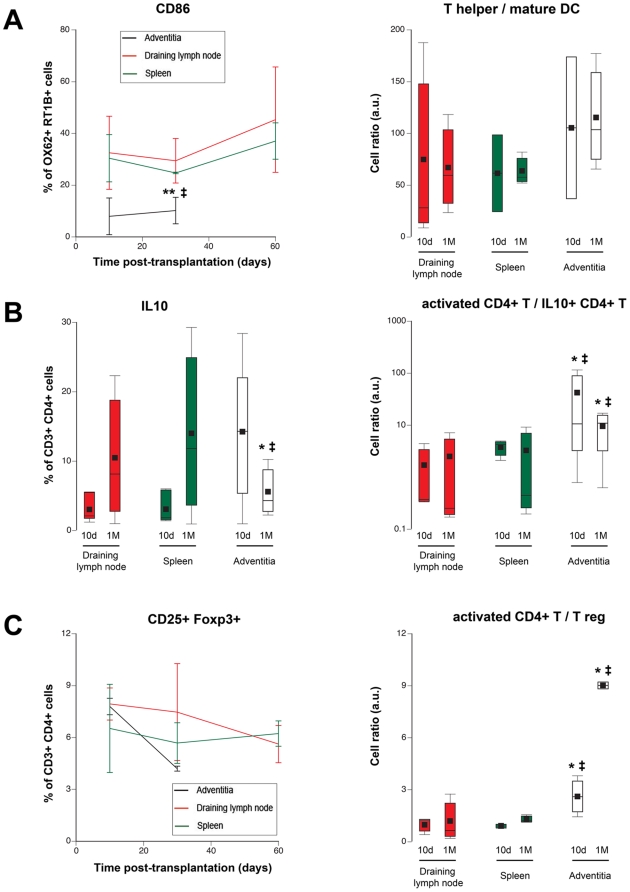
Clues for a defective immune regulation in TLT.
A. The percentage of CD86-expressing mature dendritic cells (OX62+ MHC II+) was measured in the three lymphoid organs (left panel). The ratio: number of CD4+ T cells/number of mature dendritic cells was also calculated (right panel). Adventitia vs spleen: ‡ p<0.05; adventitia vs draining lymph node: ** p<0.01. B. The percentage of IL10-producing CD4+ T cells (Tr1) dropped in TLT between 10 days and 1 month post-transplantation, an evolution inverted as compared with spleen and draining lymph node (left panel). The ratio: number of activated (CD25+ Foxp3−) CD4+ T cells/number of Tr1 cells was increased in TLT at each time points (right panel). Adventitia vs spleen: ‡ p<0.05; adventitia vs draining lymph node: * p<0.05. C. The percentage of regulatory T cells (CD4+ CD25+ Foxp3+) tended to decrease in TLT between 10 days and 1 month post-transplantation (left panel). The ratio: number of activated (CD25+ Foxp3−) CD4+ T cells/number of T reg was increased in TLT at each time points (right panel). Adventitia vs spleen: ‡ p<0.05; adventitia vs draining lymph node: * p<0.05.